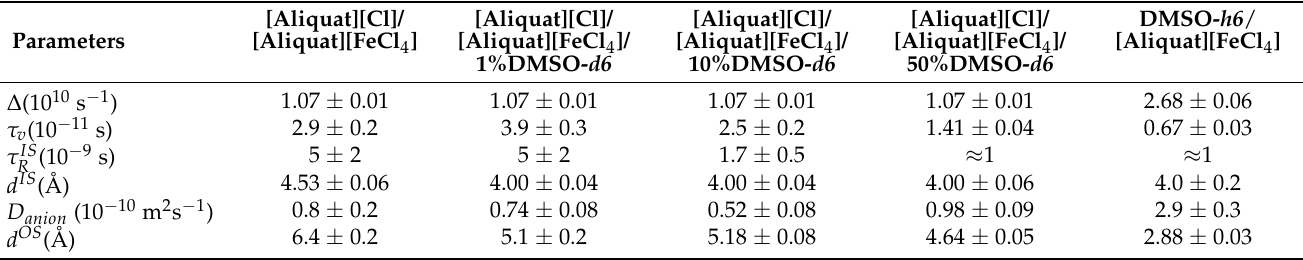
Table 5. Parameters obtained from the NMRD fitting of the paramagnetic samples at 25 ◦ C. The sensitivity of the global fit to each parameter was used as an estimation of the respective uncertainty. The MIL is always at 1% ( v/v ) concentration. S , the value of the electronic spin, was set to 2.5, the molar mass and density of the solvent (non-magnetic part of the mixture) were extracted from Table 1, q was set to one. F and τ m were calculated as explained in the text.